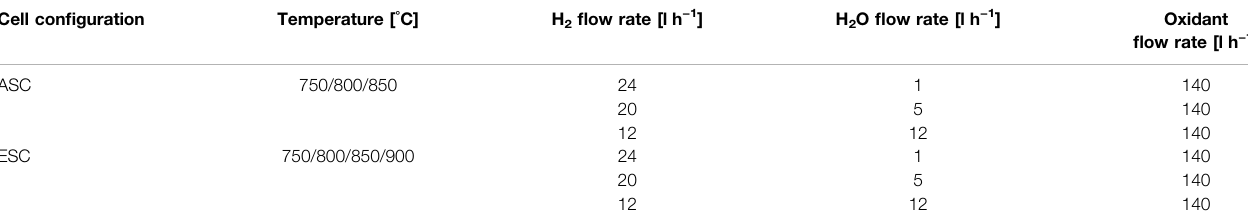
TABLE 1 | Summary of different working conditions at which cell fi ngerprints were recorded. Cell con fi